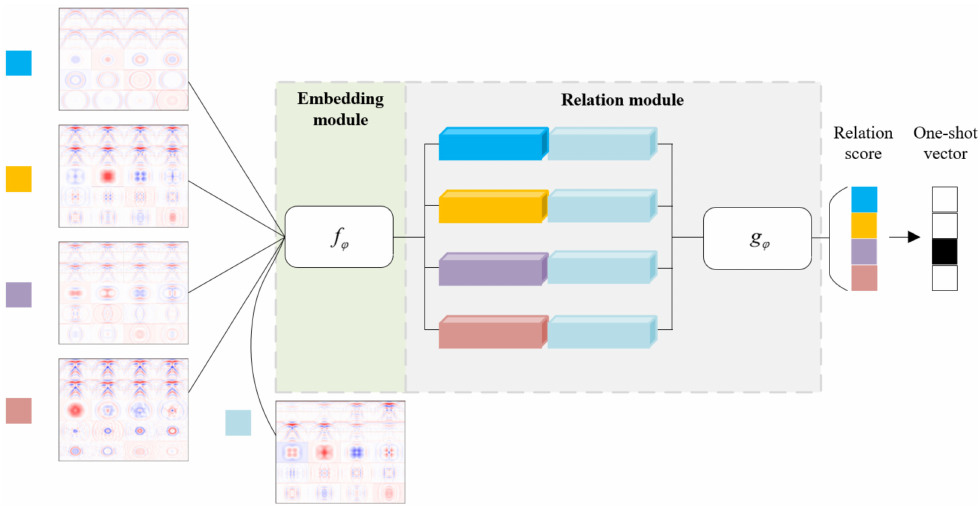
Figure 7. FSL architecture for a four-way one-shot problem with one query